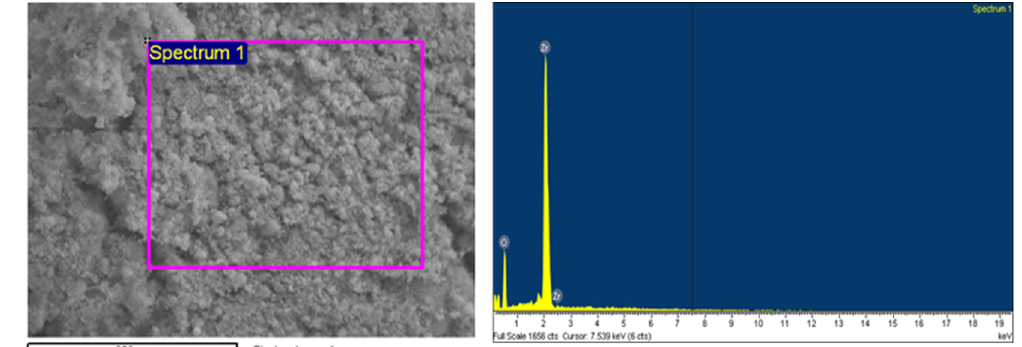
Figure 7. ( a , b ) TEM images and ( c , d ) particle size distribution of ZrO 2 nanoparticles after L.L.E by D2EHPA/p ‐ xylenes.